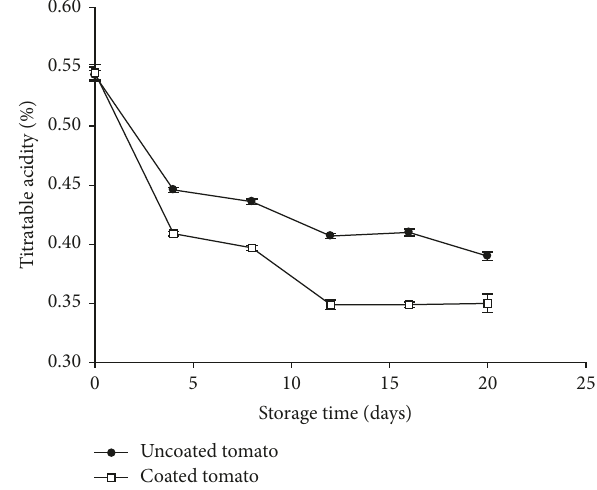
Figure 5: Total acidity response of tomatoes coated with guar gum during a 20-day storage period at ambient temperature ( 22 ± 2 ∘